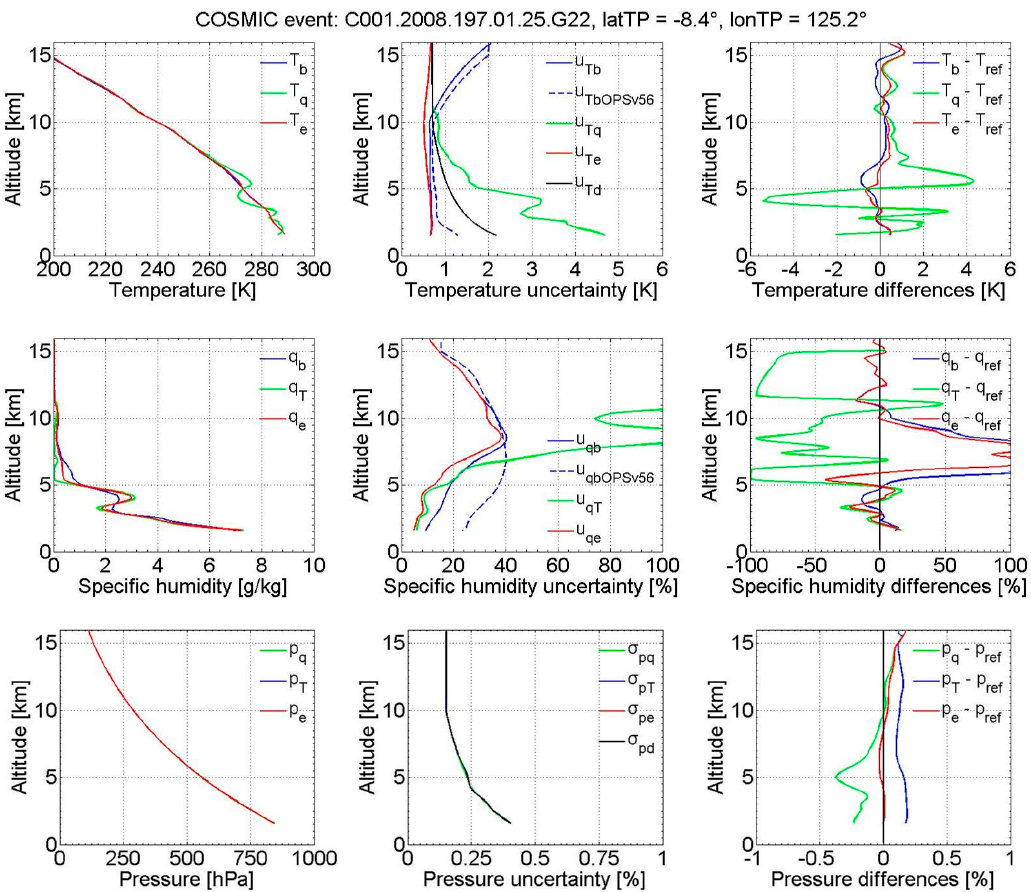
Figure 4. Illustration of input, intermediate, and result variables relevant towards the estimation of optimal temperature (top row), specific humidity (middle row), and pressure (bottom row) of an exemplary COSMIC event (identified on top), for the dynamic approach. Figure format and style are the same as for Figure 3; see that caption for